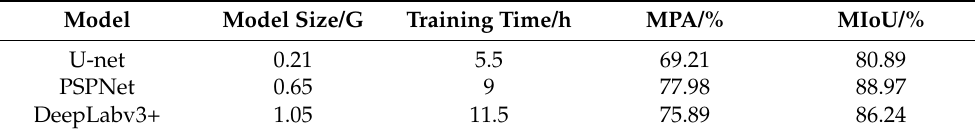
Table 4. Comparison of three different semantic segmentation